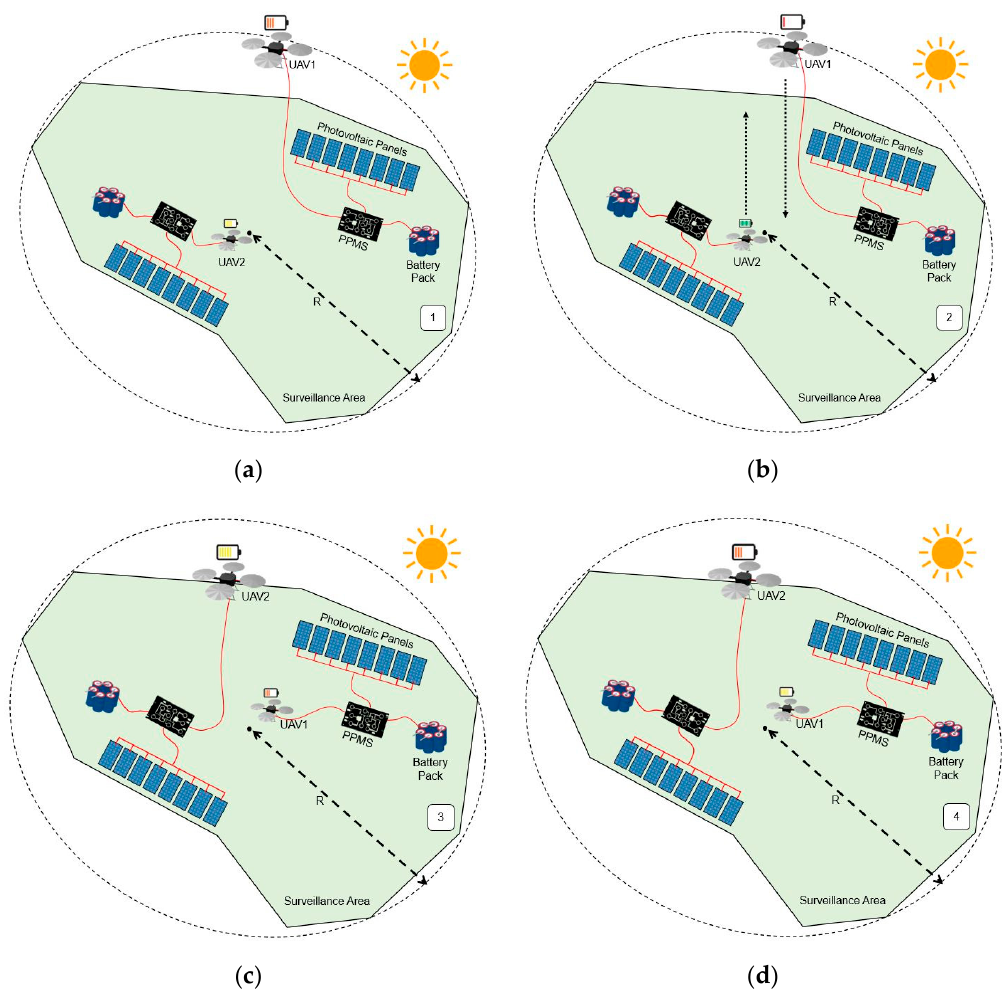
Figure 1. Step-by-step scenario of the aerial surveillance operation: ( a ) Step 1, ( b ) step 2, ( c ) step 3, and ( d ) step